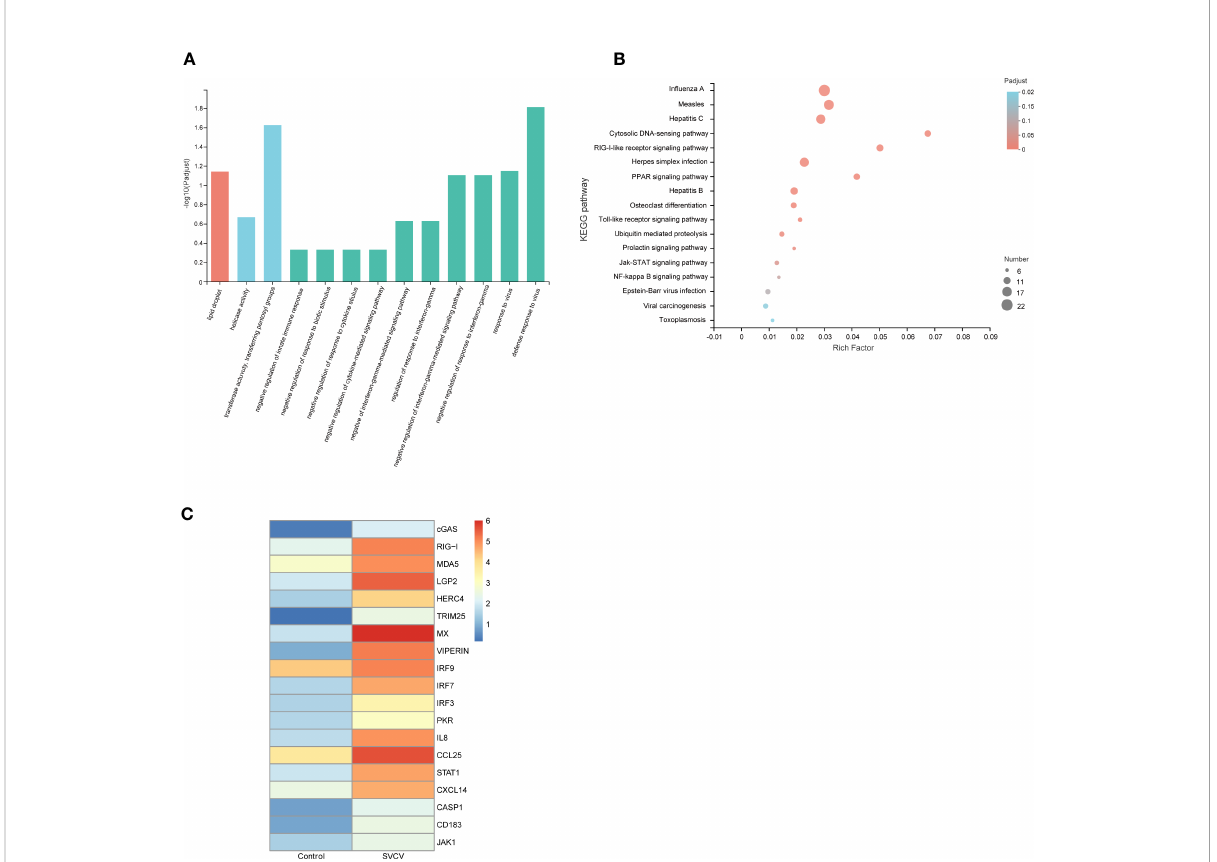
FIGURE 2 Function analysis of DEGs. (A) The gene ontology (GO) enrichment analysis of co-upregulated DEGs in gills, foregut and hindgut between the control and SVCV-infected groups. The X-axis indicates the GO terms, and the Y-axis indicates the degree of enrichment in this term. (B) The Kyoto Encyclopedia of Genes and Genomes (KEGG) enrichment analysis of co-upregulated DEGs in gills, foregut and hindgut. The X-axis indicates the rich factors of corresponding pathways, and the Y-axis indicates the pathway names. The different colors of the dots represent the q-value, and the number of DEGs in each pathway is represented by the size of the dots. (C) A heatmap plot of DEGs involved in infectious diseases and immune-related pathways that are enriched in the control group versus the SVCV-infected